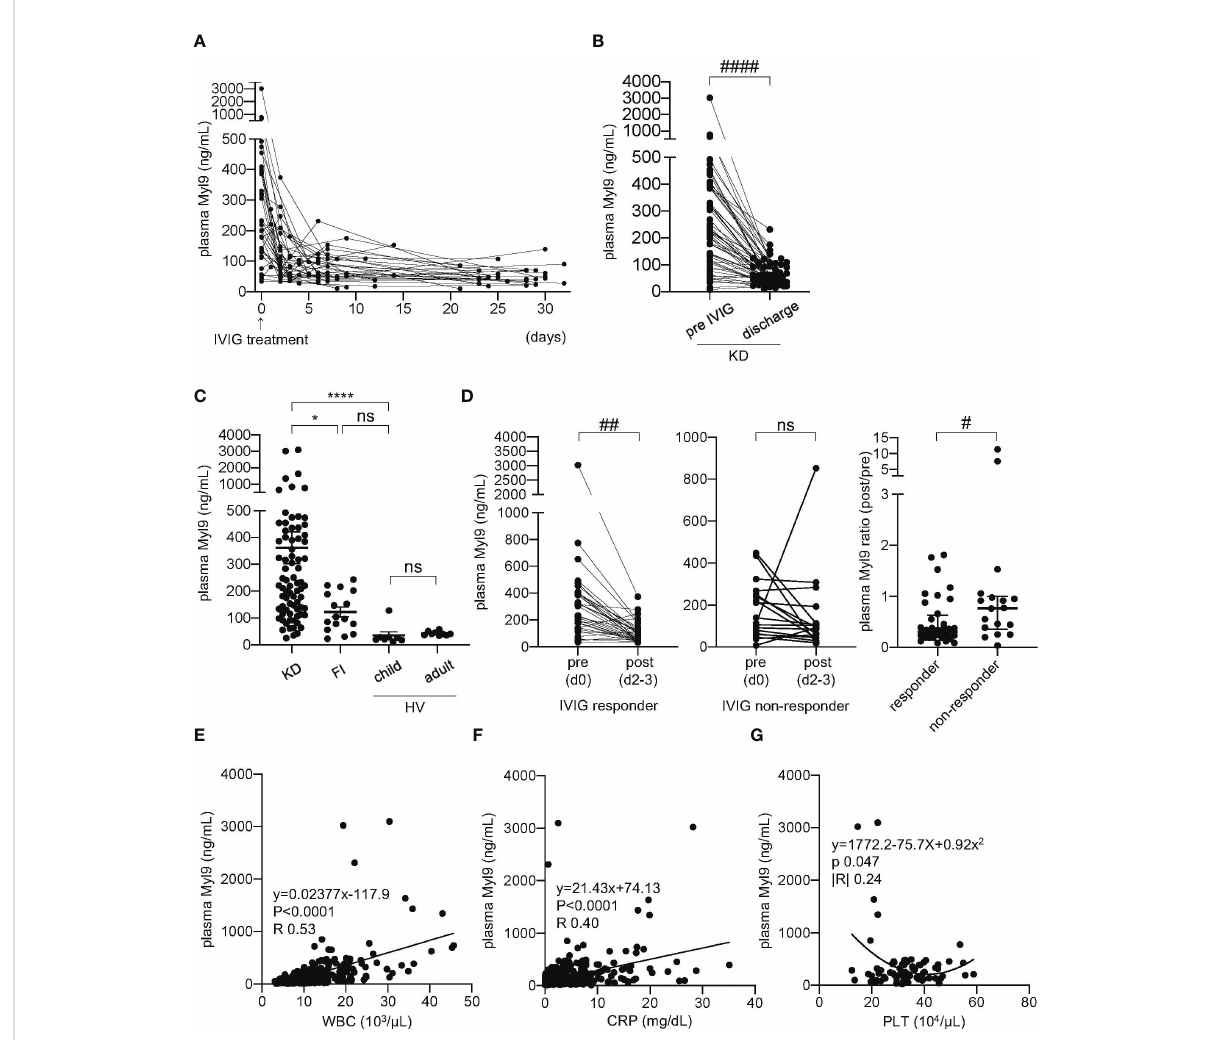
FIGURE 1 Plasma Myl9 levels correlate with KD clinical course. (A) A time-course analysis of plasma Myl9 levels in 36 KD patients who responded to IVIG treatment. Day 0 values are values of samples obtained just before IVIG treatment, and the same patient samples are connected by a line. (B) Comparison of the plasma Myl9 levels in the acute phase (pre-IVIG and at discharge of KD patients (n=54). The same patient samples are connected by a line. #### P < 0.0001 (single comparisons, Wilcoxon signed-rank test without correction). (C) Comparison of the plasma